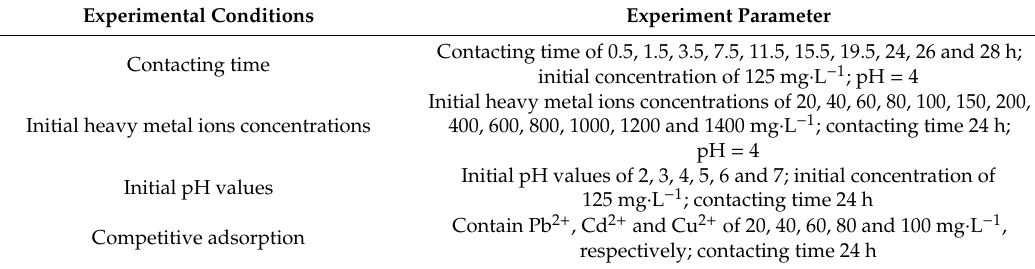
Table 3. Batch mode experimental